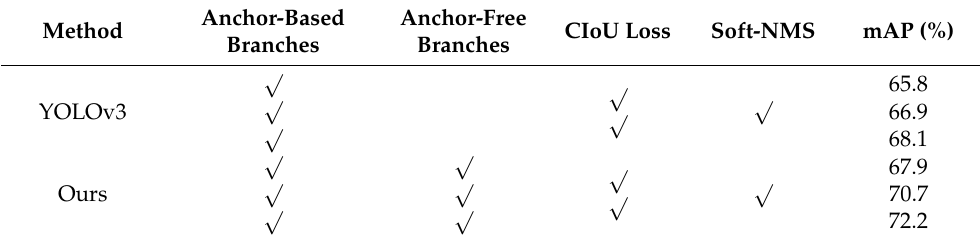
Table 2. Ablation experiment of YOLOv3 detector and our improved detector on the infrared image